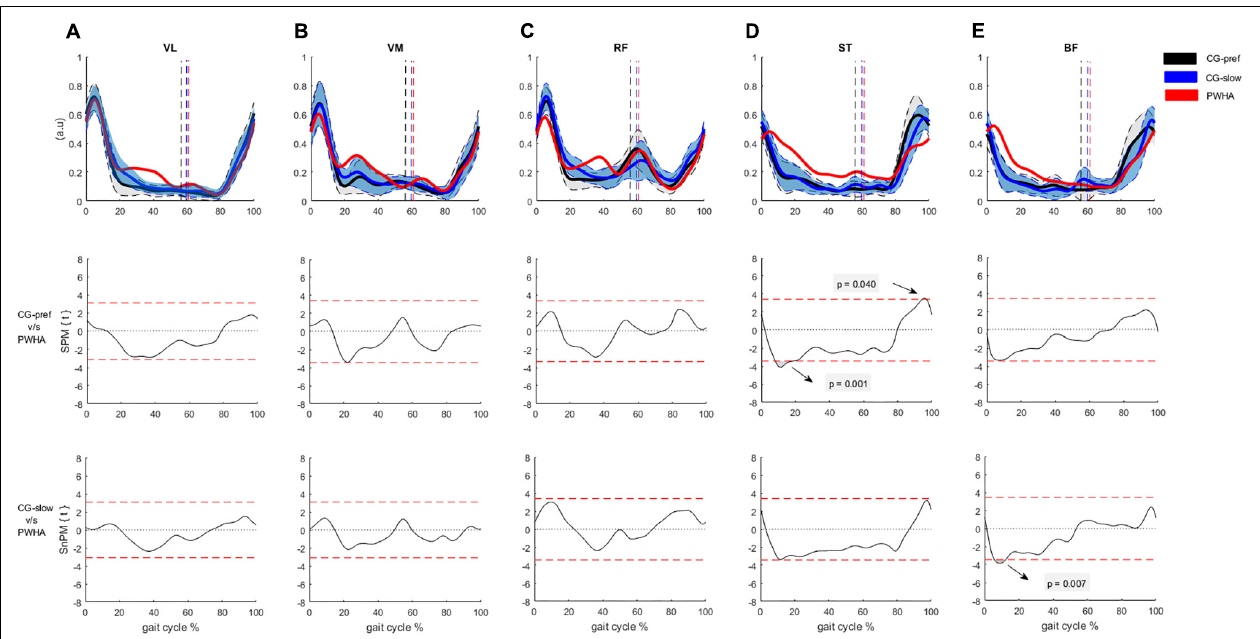
FIGURE 3 | Comparison between groups of surface electromyography of muscles crossing the knee. (A) Vastus lateralis (VL). (B) Vastus medialis (VM). (C) Rectus femoris (RF). (D) Semitendinosus (ST). (E) Biceps femoris (BF). (Top row) Surface electromyography of muscles crossing the knee of people with hemophilic arthropathy (PWHA; n = 14) at their preferred velocity (red), the control group ( n = 13) at their preferred velocity (CG-pref, black), and during the slow velocity condition (CG-slow, blue). Data are plotted as a function of normalized step time (0, heel strike) and expressed as mean with 95% confidence interval for CG. Vertical dashed lines indicate transition from stance to swing phase (black, CG-pref; blue, CG-slow; red, PWHA). (Bottom two rows) Time-dependent t values of the statistical parametric mapping (SPM) for groups comparison. Horizontal red dashed line indicates p = 0.05 level. Gray zones indicate regions with statistically significant differences. a.u, Arbitrary